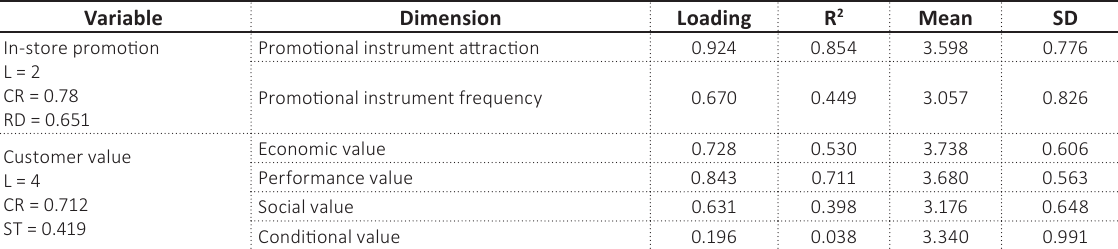
Table 3. Second-order measurement model